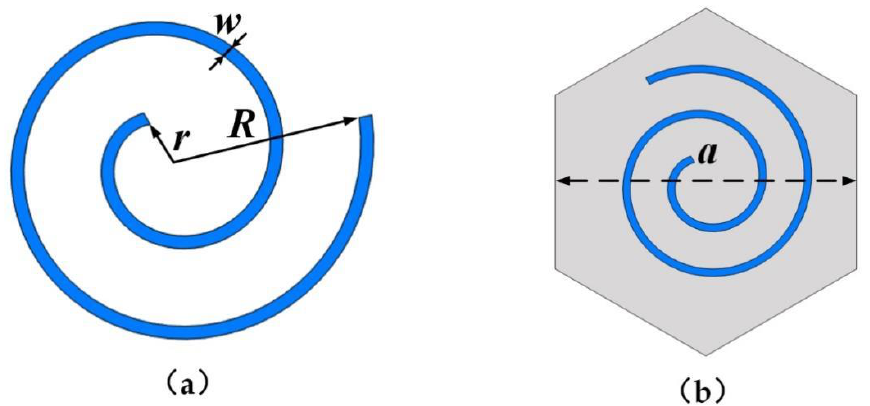
Figure 1. ( a ) Schematic of an Archimedean spiral with its geometric parameters. ( b ) The left-handed spiral distributed in honeycomb unit cell.